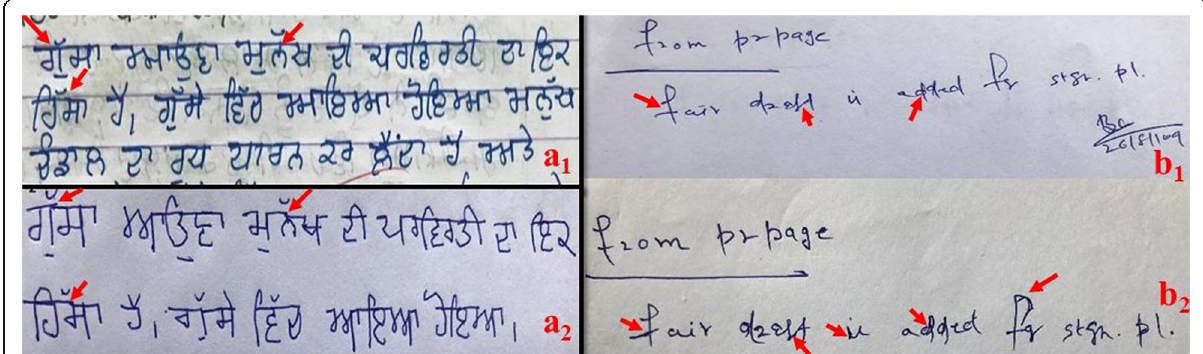
Fig. 3 Pen lifts and retouching/overwriting. a 1 Handwriting before onset of RA showing consistency of strokes and no retouching/overwriting. a 2 Inconsistent pen lifts in handwriting of RA patient. b 1 Absence of retouching to make correction in handwriting of RA patient. b 2 Extra lines to rejoin strokes at place of unnatural pen lifts along retouching and overwriting to make cautious corrections in copied